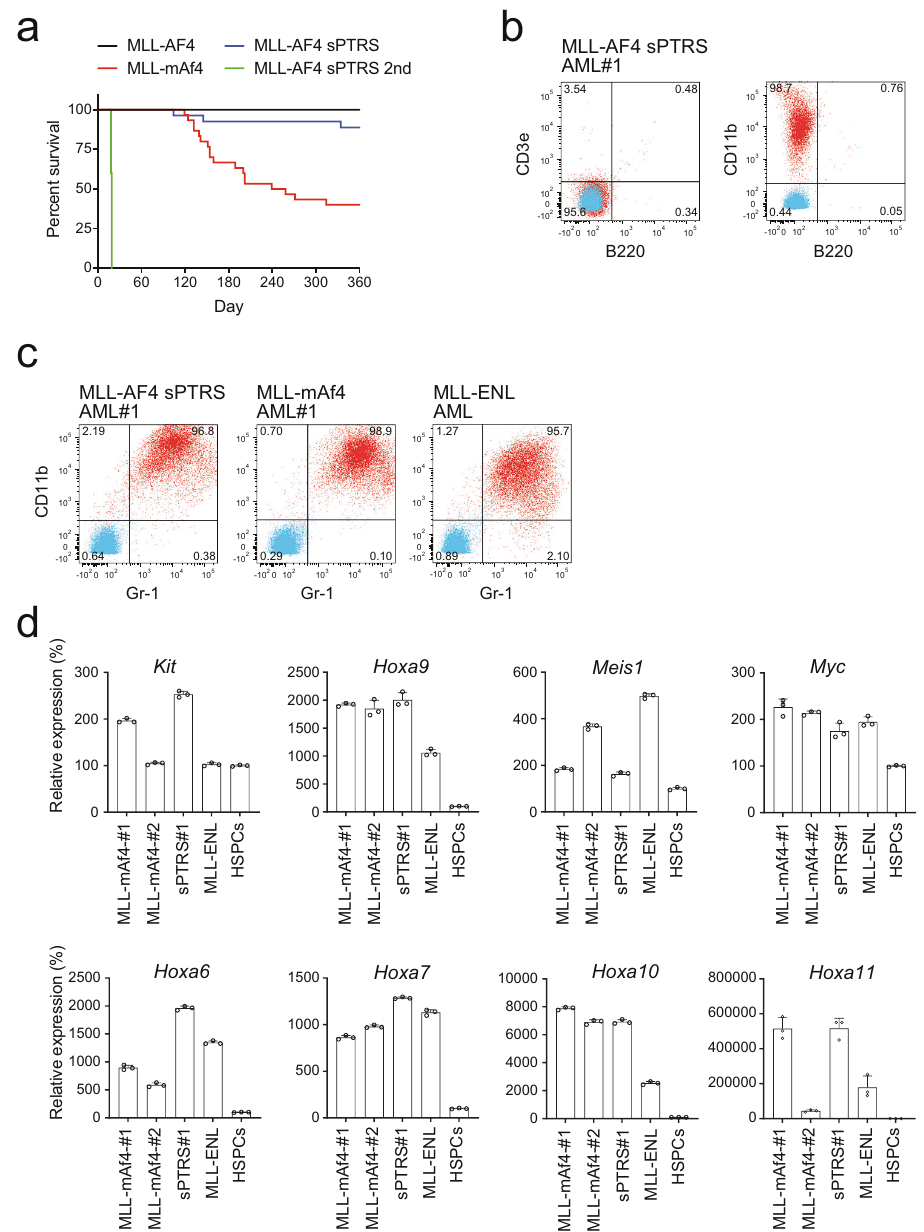
Fig. 3 | A synonymous mutant of MLL-AF4 induces leukemia. a Leukemogenic potentialofMLL-AF4sPTRSinvivo.MurineHSPCsweretransducedwithretrovirus for the MLL-AF4 sPTRS construct and transplanted into syngeneic mice. MLL-AF4 sPTRS, n =30.TheB/M-MPALandT-ALLcaseswereexcludedasretrovirusgenome sPTRS-mediated leukemia. Bone marrow cells from mice with MLL-AF4 sPTRS- mediated leukemia were analyzed via fl ow cytometry for the indicated markers.